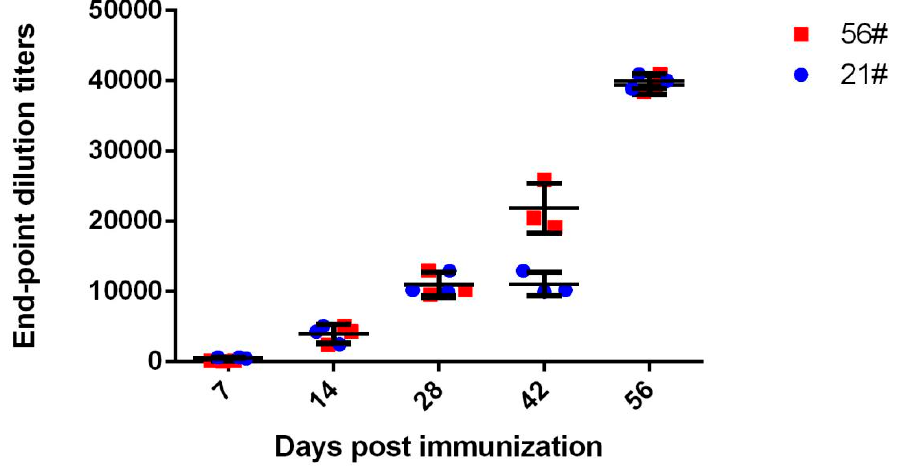
Figure 1. ELISA titers of West Nile virus (WNV) EDIII (structural domain III of the E protein)-specific antibody in immunized horse sera. Horses ( n = 2, labeled as 21# and 56#) were intramuscularly immunized with WNV-VLP (virus-like particles) and boosted every two weeks for an additional four cycles. The sera were collected 2 weeks after each immunization.